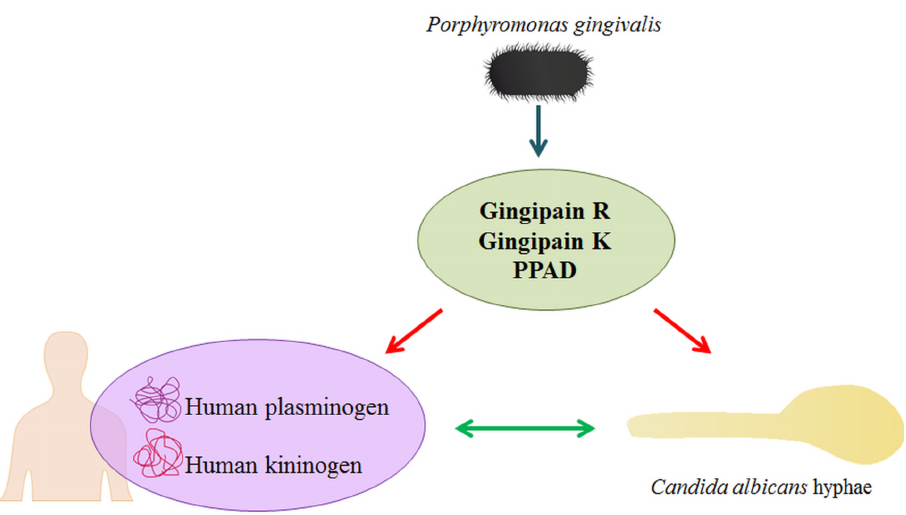
Figure 1. The impact of P. gingivalis secretory proteins on C. albicans and human plasma proteins. The activity of bacterial cysteine proteases (gingipains) and PPAD results in the citrullination of different proteins. During infection, in the inflammatory milieu, PPAD can citrullinate both human plasma proteins and fungal surface-exposed proteins, thereby affecting the interactions between the fungus and human proteins and modifying the level plasma protein binding by C. albicans .